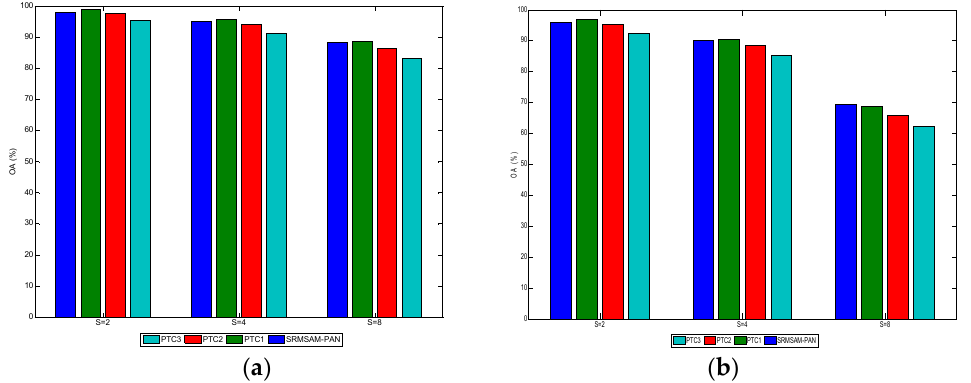
Figure 16. ( a ) OA (%) of SRMSAM-PAN and pansharpening technique then classification (PTC) in experiment 2 ( b ) OA (%) of SRMSAM-PAN and PTC in experiment 3.